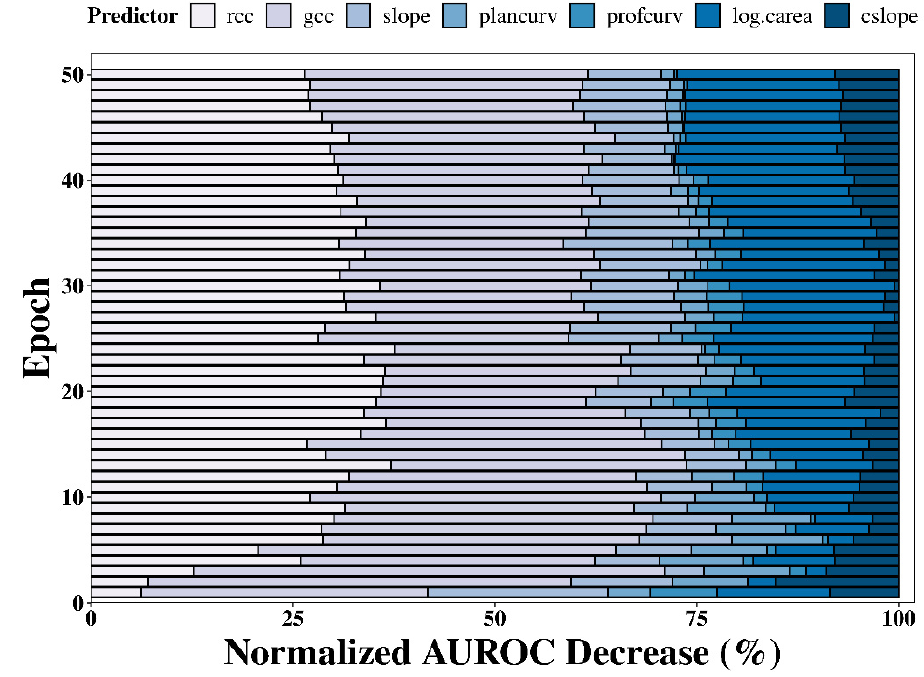
Figure 6. Variable importance plot for SVM using margin sampling in each epoch.